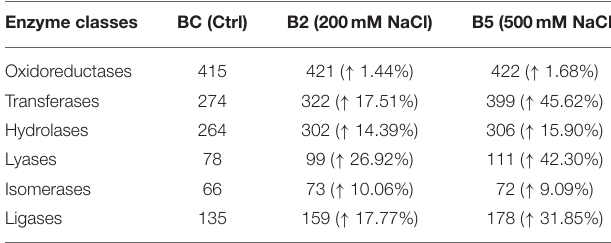
TABLE 2 | Enzyme code distribution differences as compared to control in the cell-free supernatant of Bacillus thuringiensis NEB17 under salt